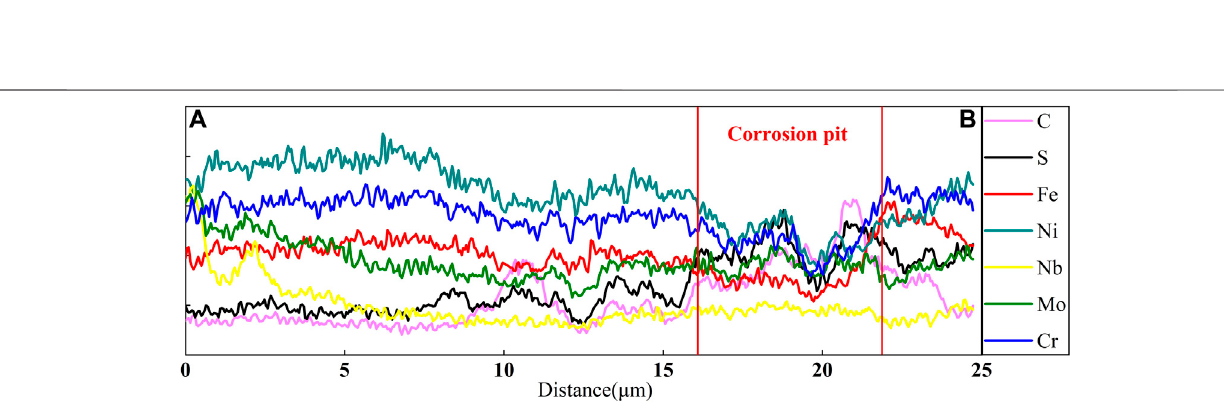
FIGURE 12 | Element surface scanning of the weld sample after 180 days of